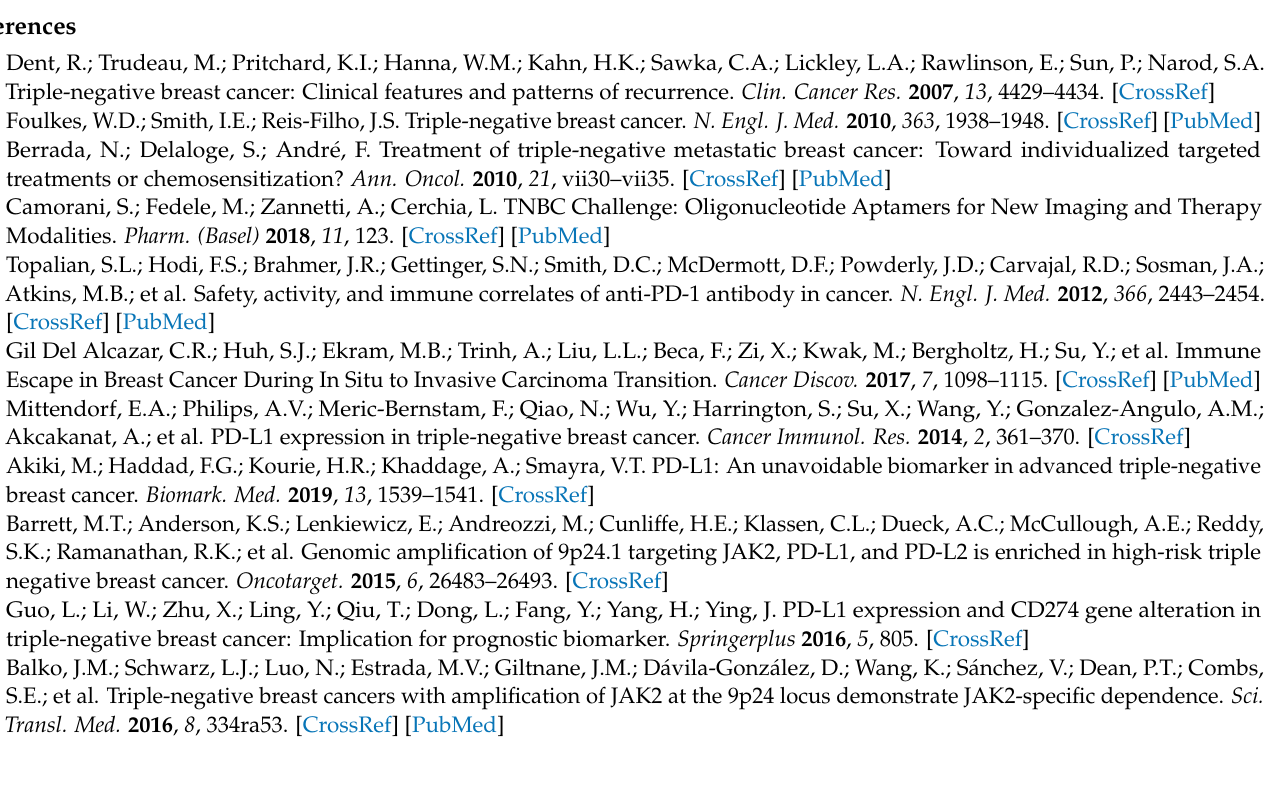
Figure S2: Quantitative determination of PD-L1 siRNA entrapped in the nanoparticles; Figure